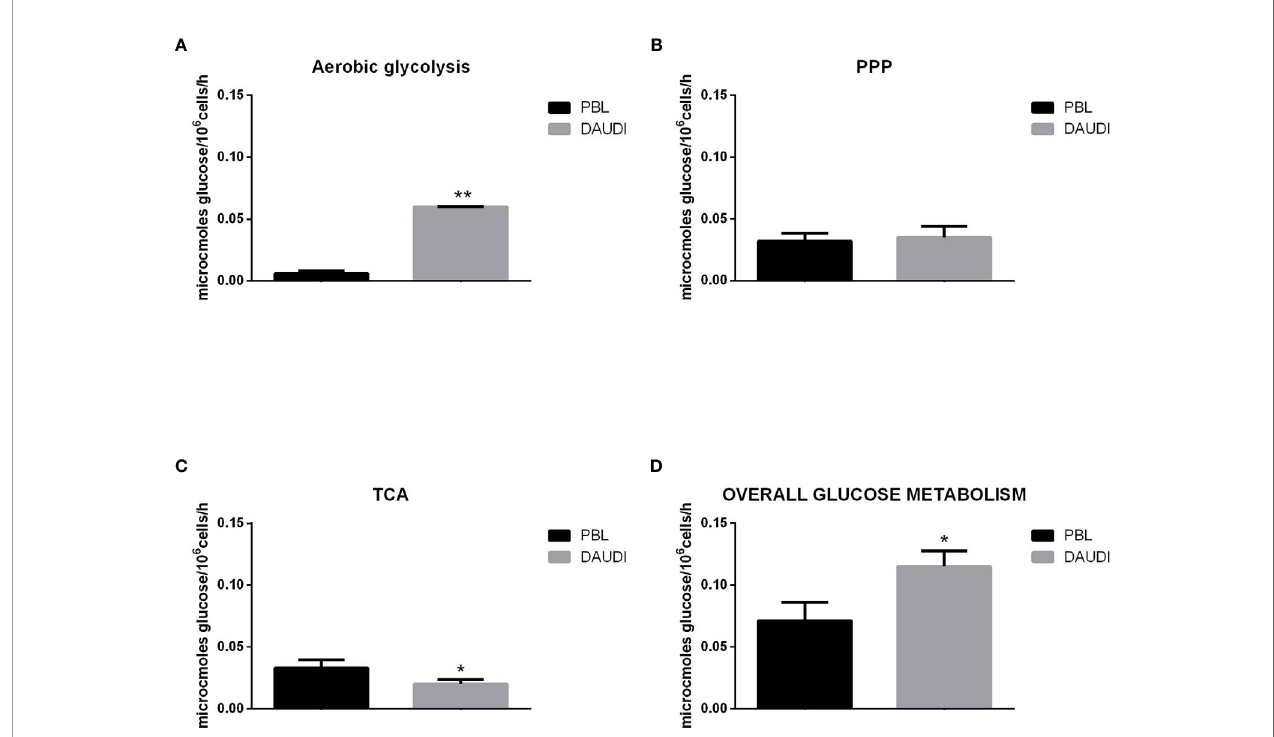
FIGURE 4 | Glucose metabolism in DAUDI cells vs . PBL. Values are means and SEM of four independent experiments (Wilcoxon signed rank test, two-tailed; *p-values ≤ 0.05; **p-values < 0.005). (A) Bars represent the rates of glucose consumption in aerobic glycolysis leading to lactate production. Effective rates of utilization of radiolabeled glucose in PPP (B) and TCA (Krebs) cycle (C) was evaluated by administration of [1-C 14 ]-glucose or [6-C 14 ]-glucose and subsequent monitoring of the emitted 14 CO 2 , which is directly proportional to the consumed glucose. PPP rates were determined as the difference between the rates of radiolabeled carbon dioxide production from [1-C 14 ]- and [6-C 14 ]-glucose. TCA cycle rates were determined by monitoring the production of radiolabeled carbon dioxide only produced by [6-C 14 ]- glucose. Overall glucose consumption (D) was calculated as the sum of glucose consumption in aerobic glycolysis, PPP and TCA